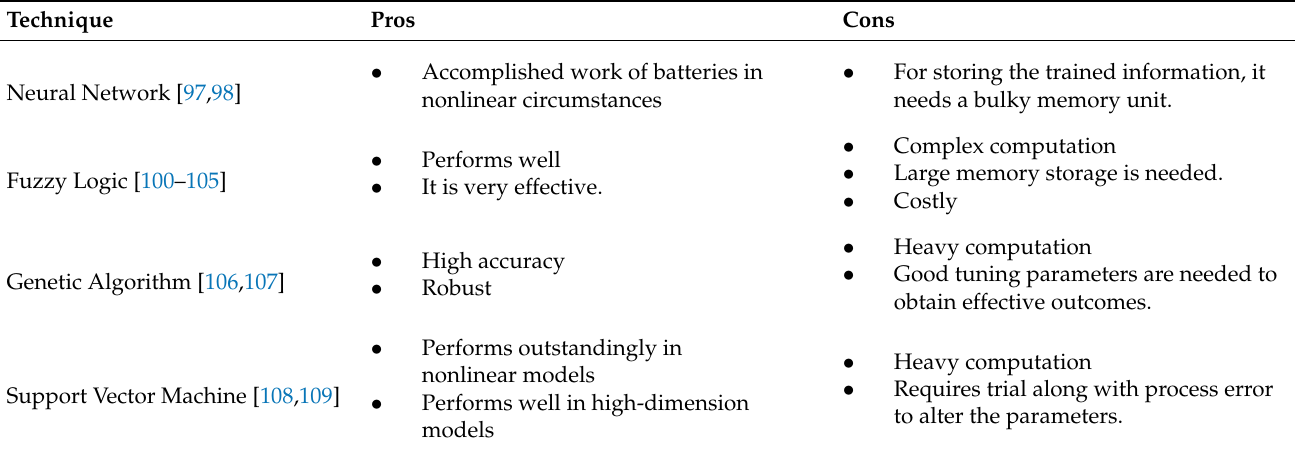
Table 7. Analysis of the different learning SOC estimation